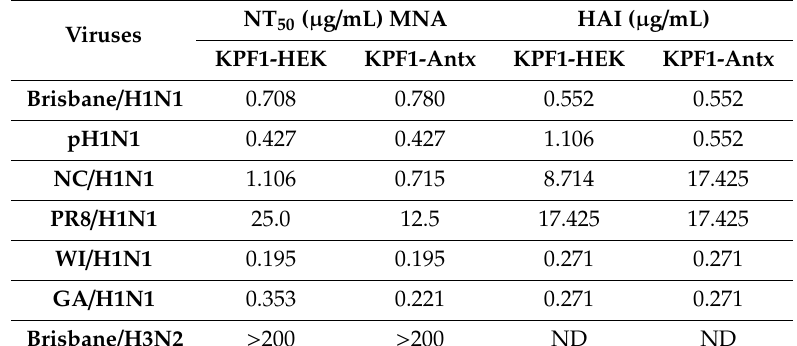
Table 1. MNA and HAI assays with KPF1-HEK and KPF1-Antx hMAbs.